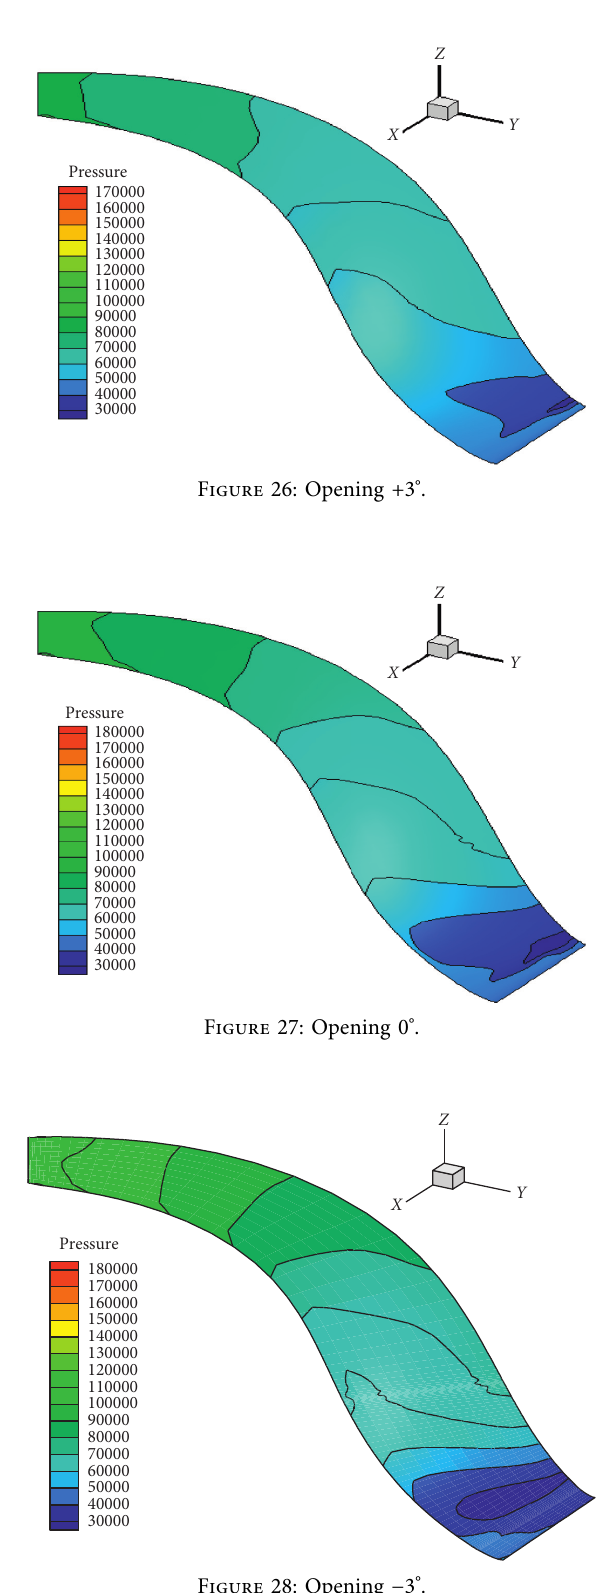
Figure 28: Opening − 3 ° .